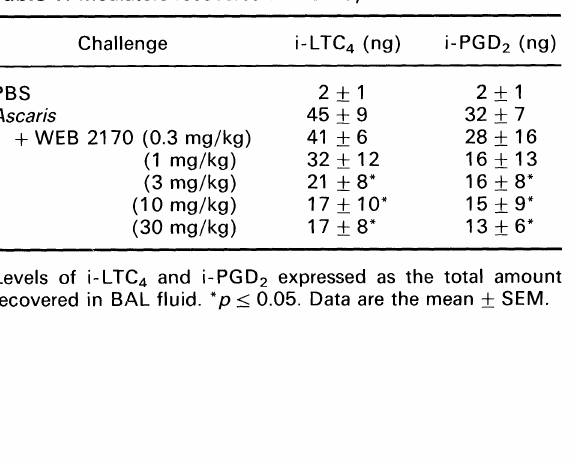
Table 1. Mediators recovered in monkey BAL fluid